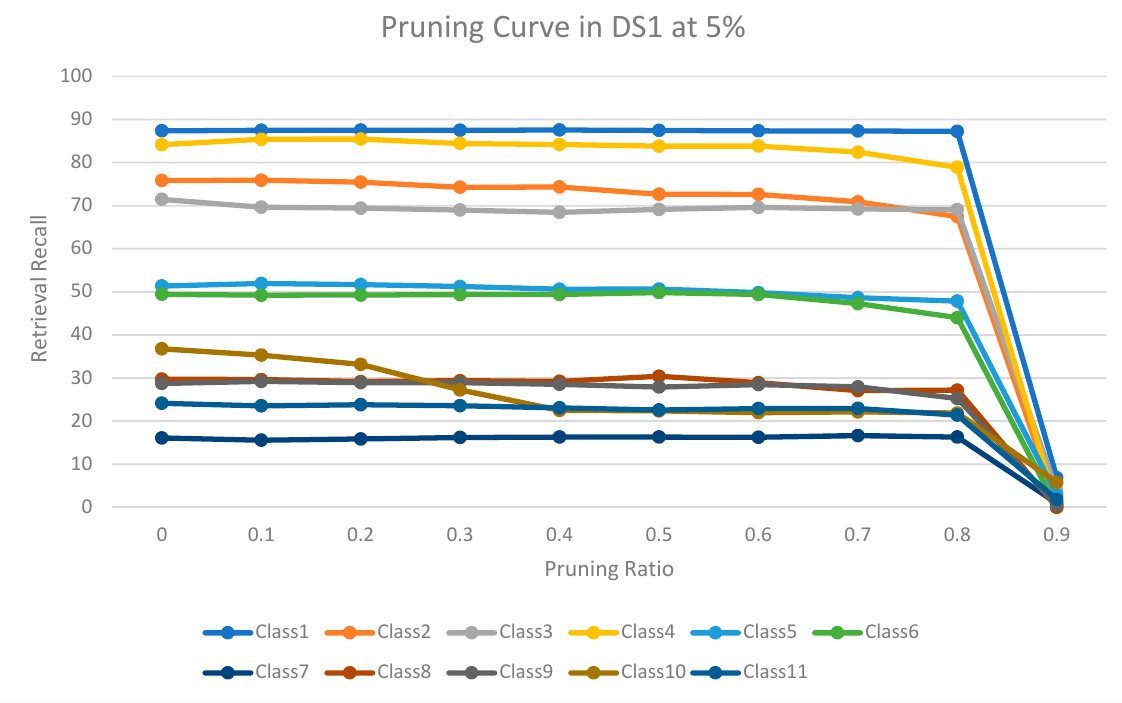
Figure 5. The level of retrieval recall values at different percentages of pruning at the top 5% in MDDR-DR1. Figure 6 shows the level of retrieval recall values at different pruning ratios for each class at the top 1% in DS2. We note that the recall values of most classes remain the same until they